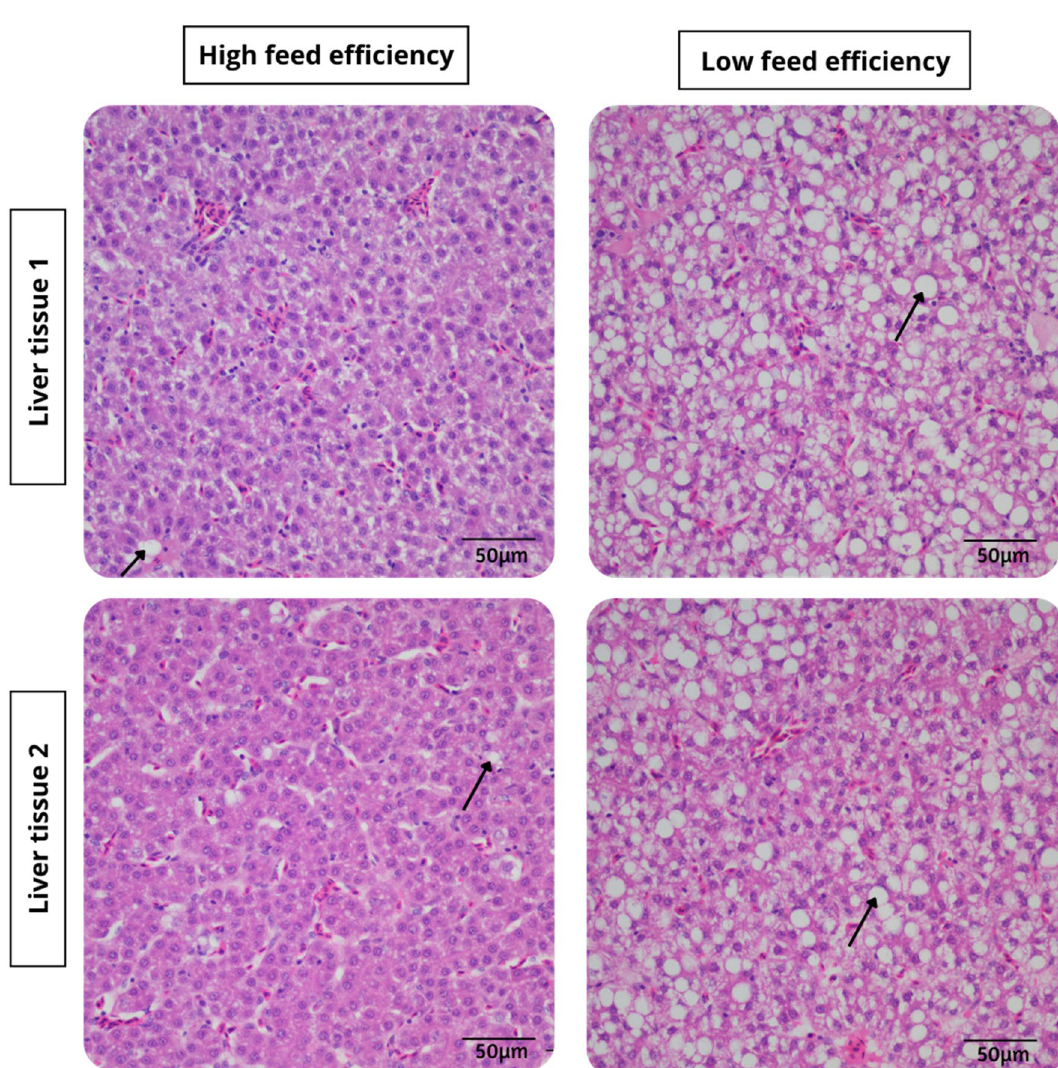
Figure 7. Images of microscopic histological sections of liver tissue after H&E staining, showing liver cells (hepatocytes) of individually housed ISA Brown hens ranked based on feed efficiency. Liver samples were taken when hens were aged 45 weeks. Steatosis within the cytoplasm of the hepatocytes is identified with a black